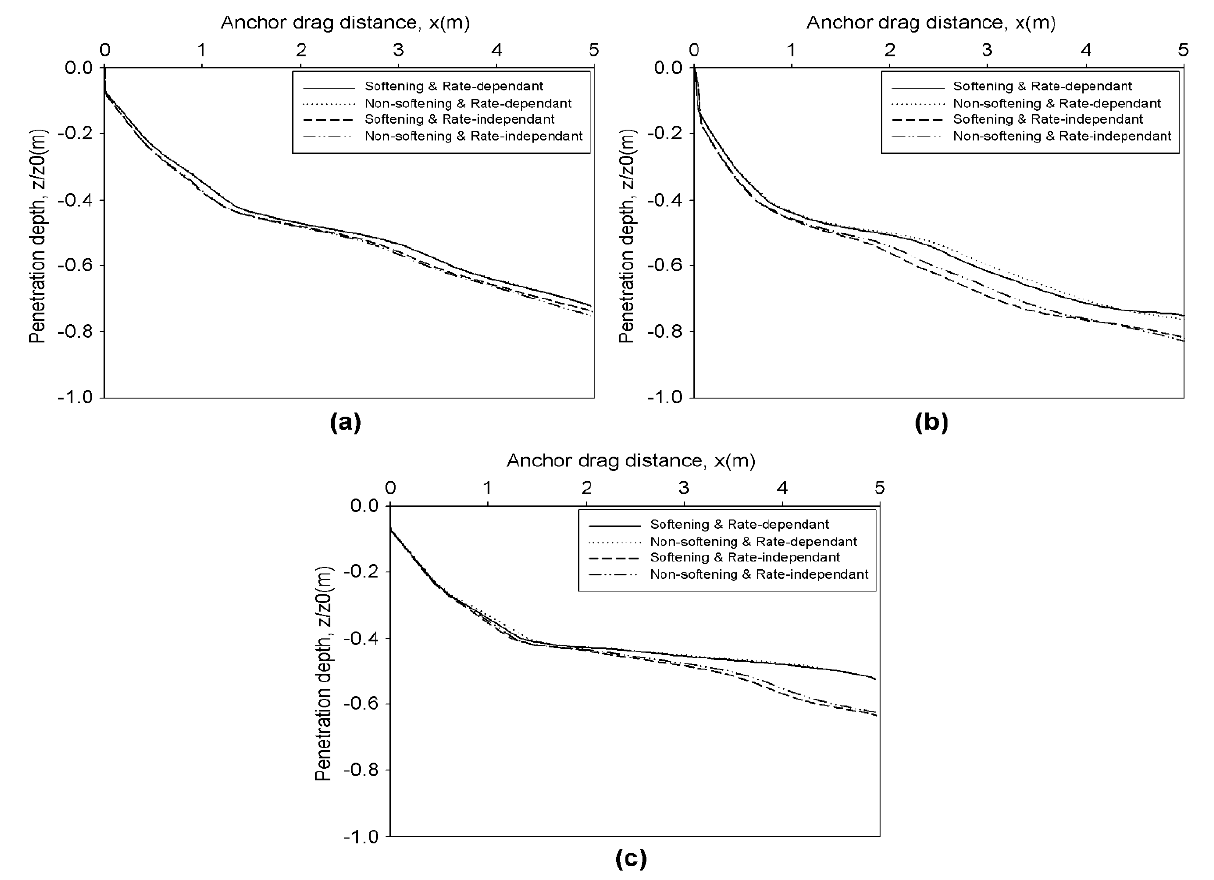
Figure 16. Anchor penetration depths obtained from TBSR–VUMAT model according to strain softening and rate: ( a ) 1.1 + 4.5 z, ( b ) 1+ 0.85 z, and ( c ) 5 + 2 z.